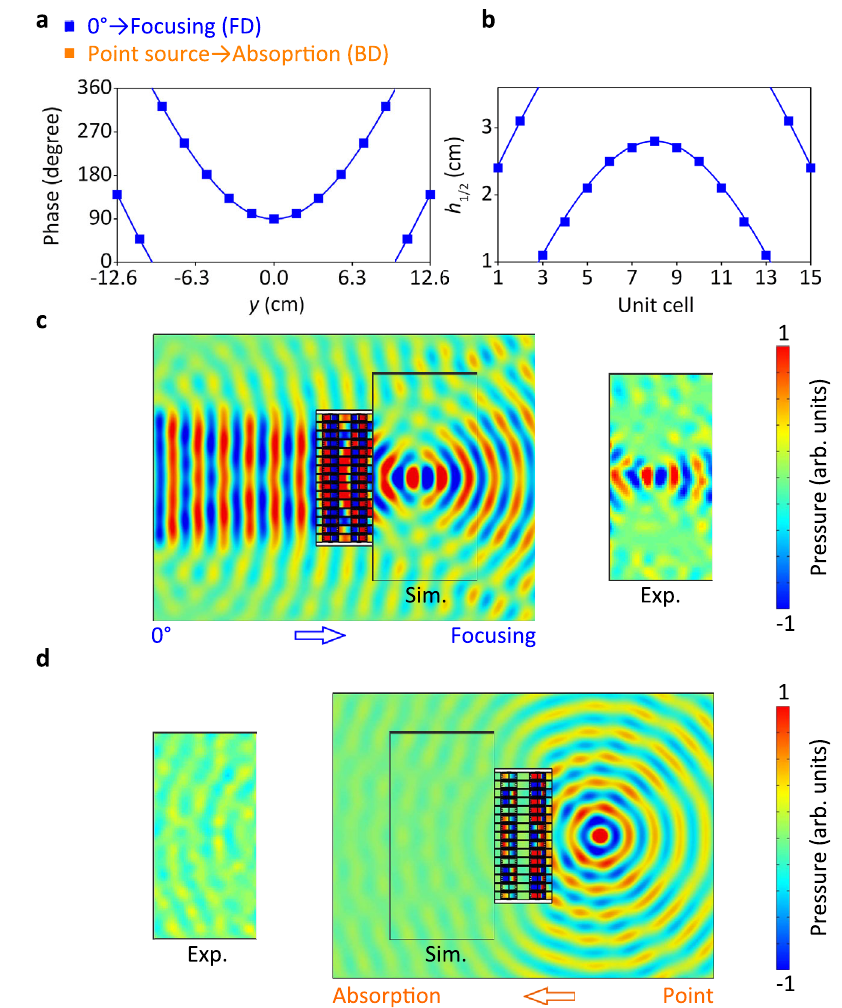
Fig. 6 Nonreciprocal acoustic wavefront manipulation for acoustic focusing. In the FD (forward direction), the normal plane incident wave is focused in a focal spot situated at x = 0 and y = 0.1 m. The time-reversed wave of this focal spot is the incident wave in the BD (backward direction), which is a point source at the same position as the focal spot. This gets totally absorbed through leakage losses, which is not the time-reverse of the incident wave from the FD demonstrating the non-reciprocity of the JAM. a Phase pro fi les along the y -direction for the FD, which is φ 1 = 117.8(( x − 0.1) 2 + y 2 ) 0.5 − 11.78 + π /2rad. For the BD, the modulators have open boundaries giving total absorption through leakage losses. b Corresponding height h 1 for the FD. c FD and d BD simulated (Sim.) and experimental (Exp.) acoustic pressure distribution at